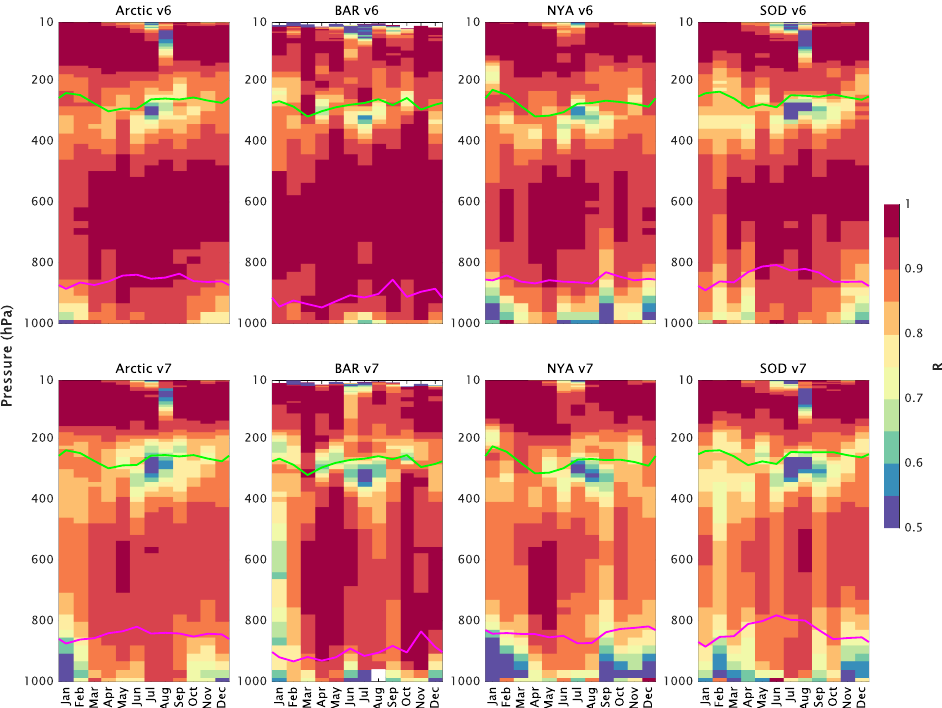
Figure 5. Same as in Figure 4, but for RMS errors between the RS92 and AIRS v6 ( upper ) and v7 ( lower ) temperature profiles.